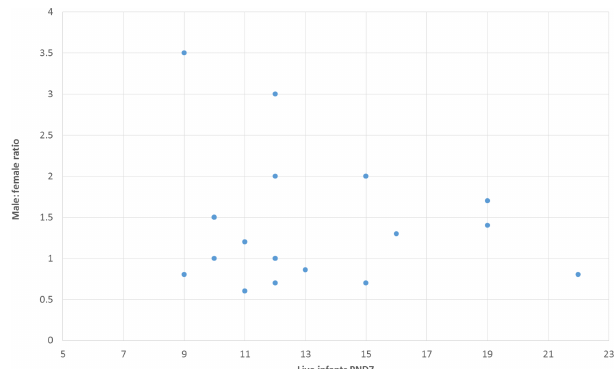
Figure 3. Comparison of male : female ratio versus number of live infants on PND7. It appears that the gender ratio is unrelated to the number of live infants (Pearson correlation coefficient: − 0 .